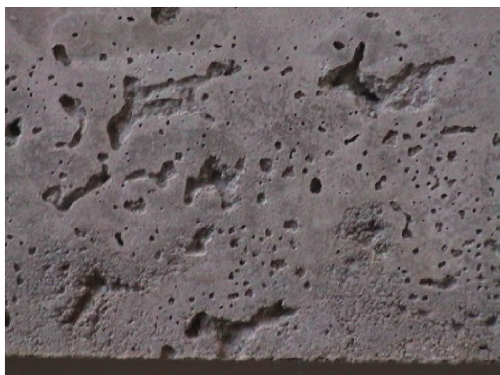
Figure 9: The section of ordinary